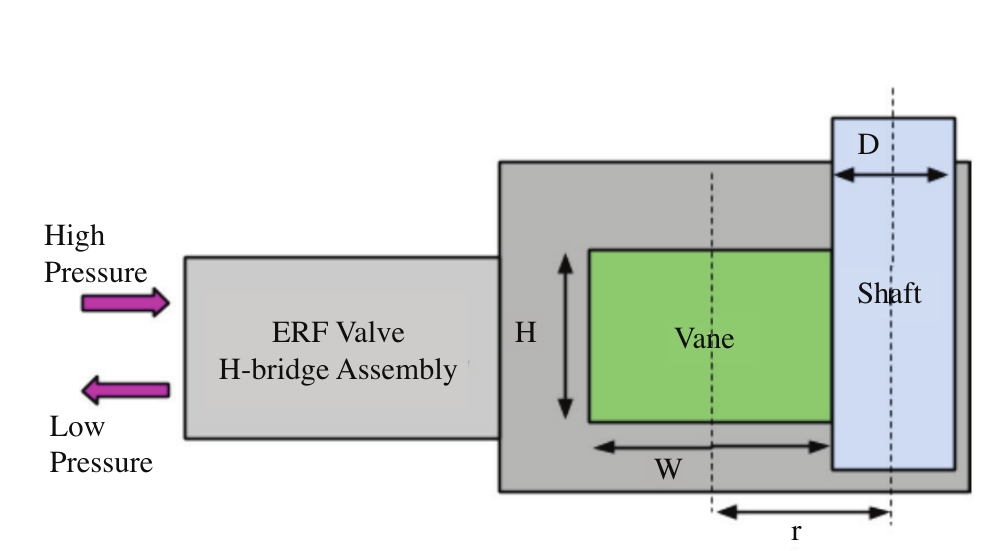
Figure 4. An ERF valve block and vane block assembly concept schematic is